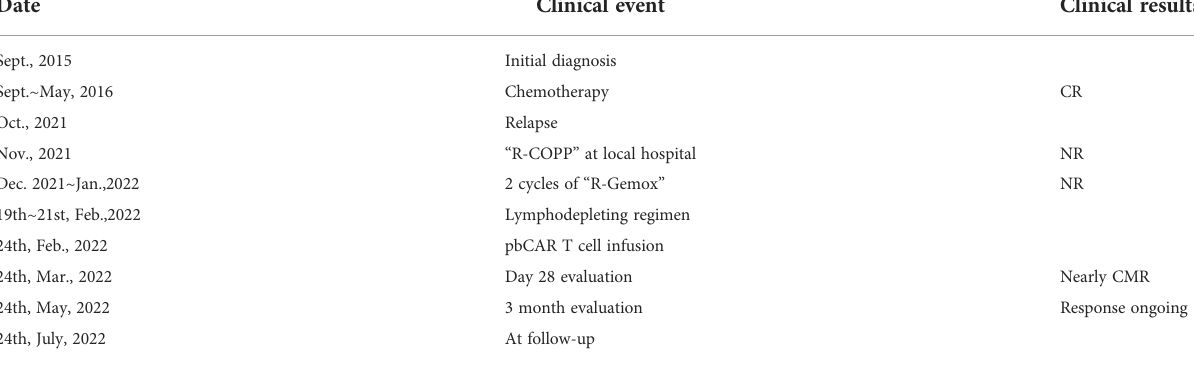
TABLE 1 The whole treatment process of the case with relapsed follicular